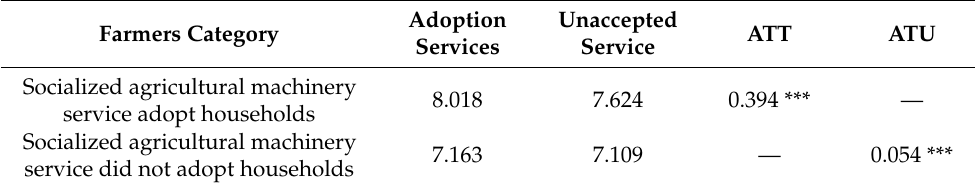
Table 5. The average treatment effect of the socialized agricultural machinery service on farmer land productivity. Adoption Farmers Category